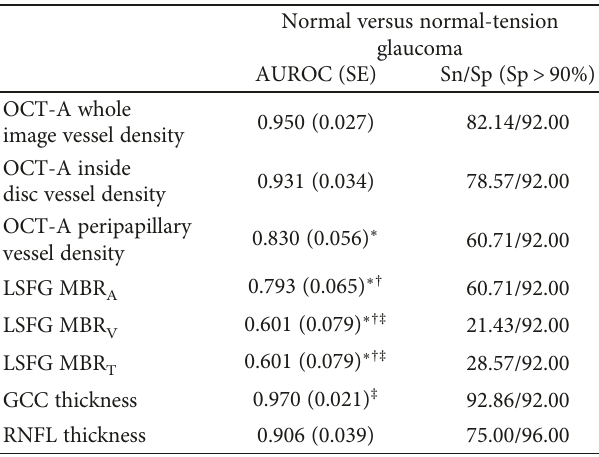
Table 5: Comparison of parameters using the area under receiver operating characteristics curve and sensitivities at fi xed speci fi cities.